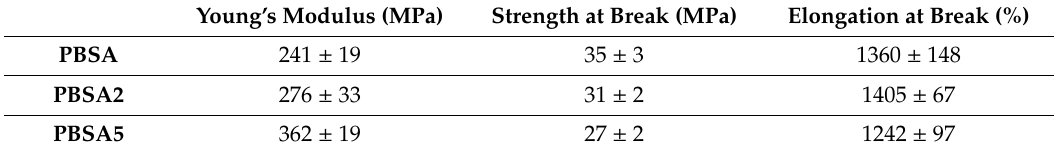
Table 2. Influence of the filler content on the mechanical properties of PBSA